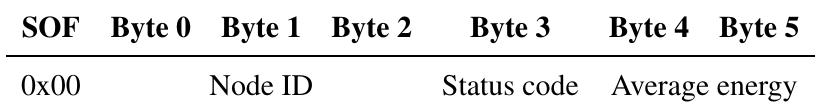
Table 1. Visible light communication (VLC) message fields. SOF,